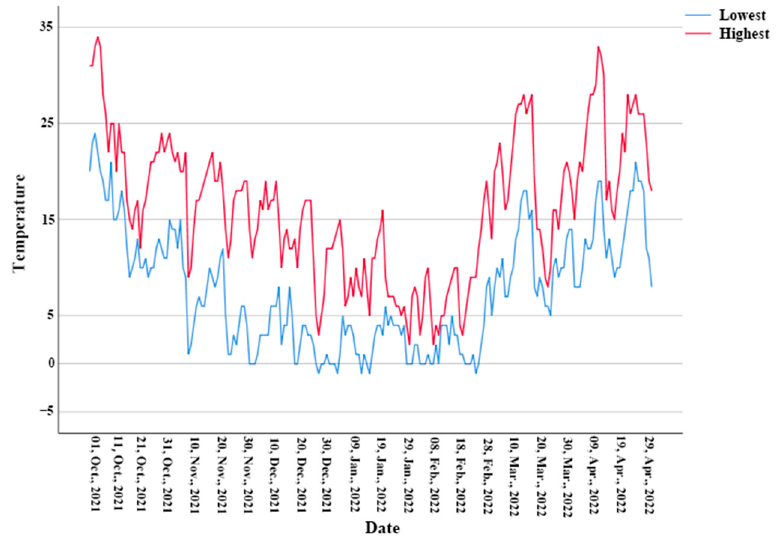
Figure 1. Lowest and highest temperatures during hibernation in the study area. The blue line shows the lowest temperature and the red is the highest temperature. the lowest temperature and the red is the highest